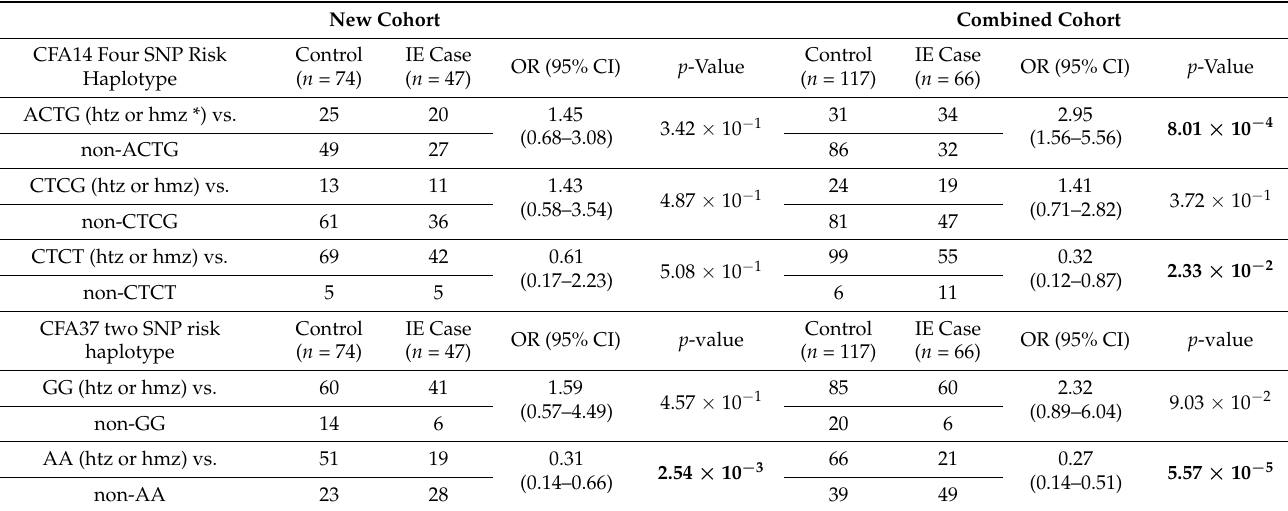
Table 1. Odds ratio (OR) and 95% confidence interval (CI) for haplotype blocks on canine chromosome 14 (CFA14) and CFA37 for Belgian shepherds for the new and combined cohorts. Haplotypes significantly associated with the risk for idiopathic epilepsy (IE) in Belgian shepherds are indicated in bold.